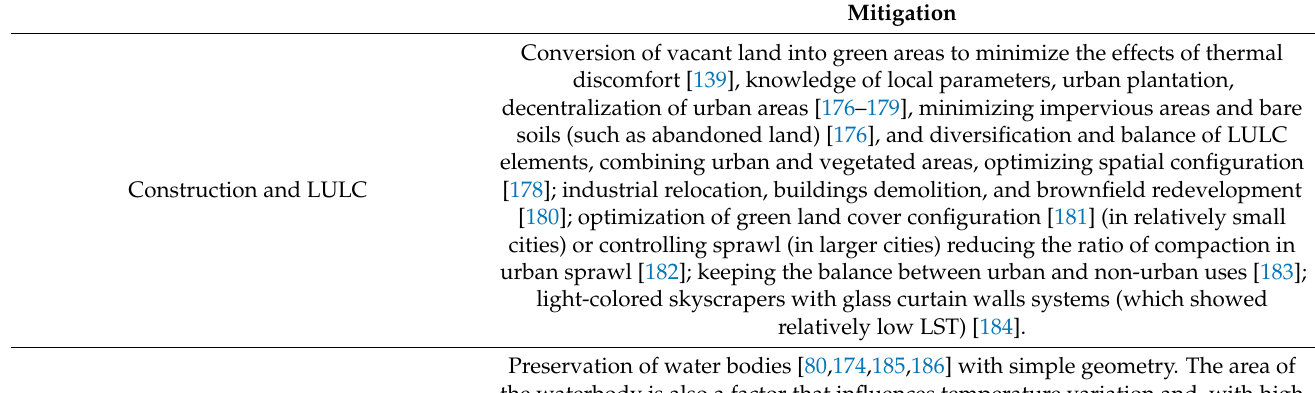
Table 16. Mitigation of the UHI and SUHI